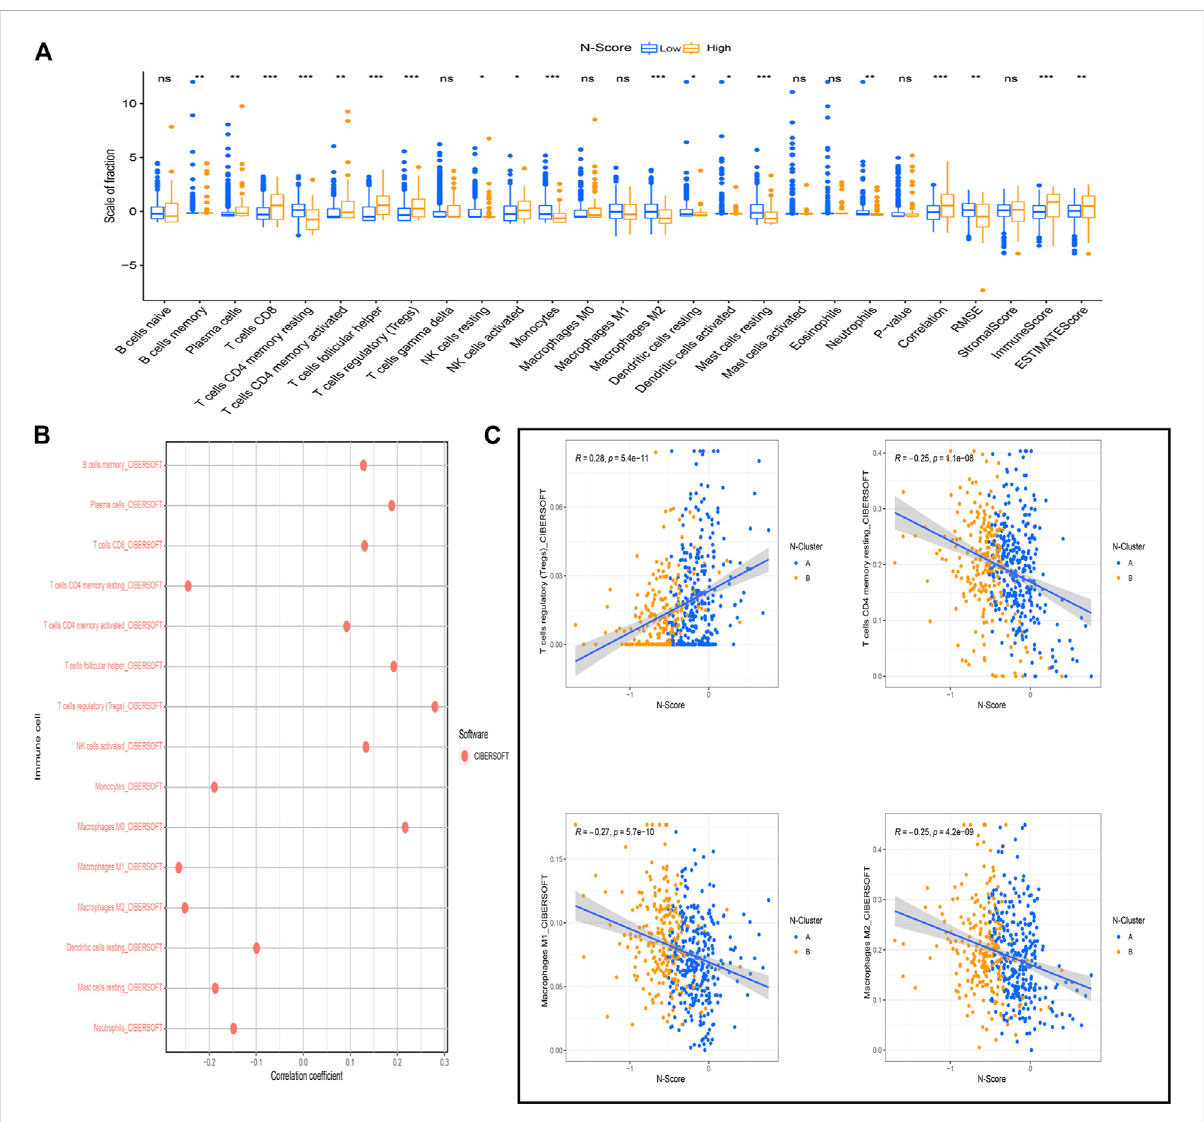
FIGURE 6 Association between N-Score and immune cells. (A) The difference of the scale of immune cells calculated by the CIBERSOFT algorithm between N-Score groups (*: p < 0.05, **: p < 0.01, and ***: p < 0.001). (B) Correlation between N-score and the scale of immune cells calculated by the CIBERSOFT algorithm. (C) Scatter diagrams reveals the correlations between N-Scores and the signi fi cant immune cells with highest coef fi cient (T cells regulatory (Tregs), T cells CD4 memory resting, Macrophages M1, and Macrophages